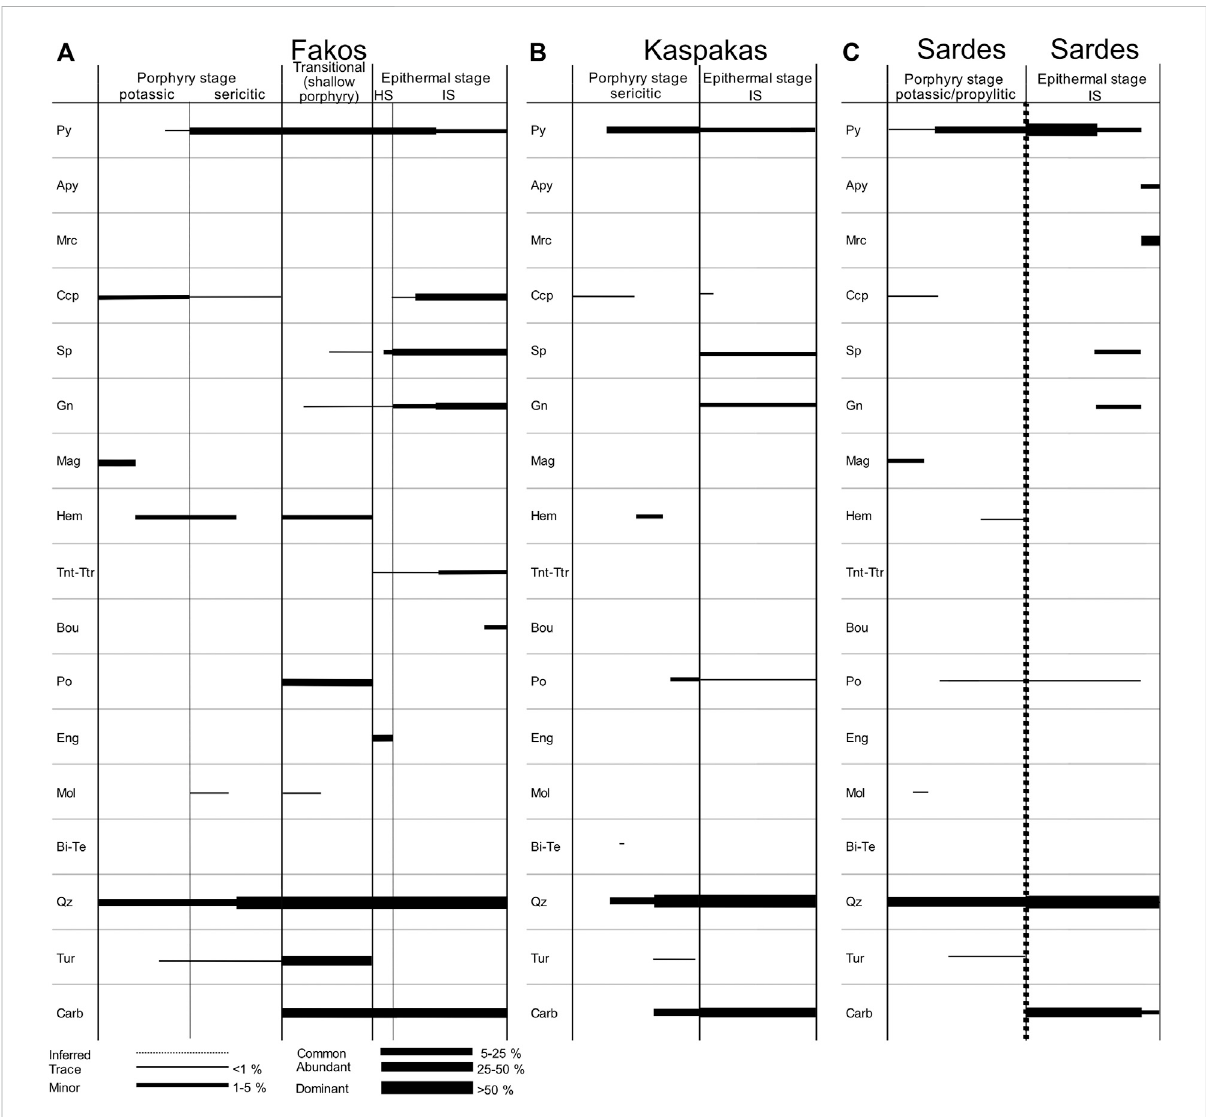
FIGURE 2 Paragenetic sequence of the three porphyry-epithermal system: (A) Fakos, (B) Kaspakas, and (C) Sardes. Note that the relation between Sardes porphyry and epithermal is unclear and therefore separated by a dashed line. Mineral abbreviations after Whitney and Evans (2010): py, pyrite;